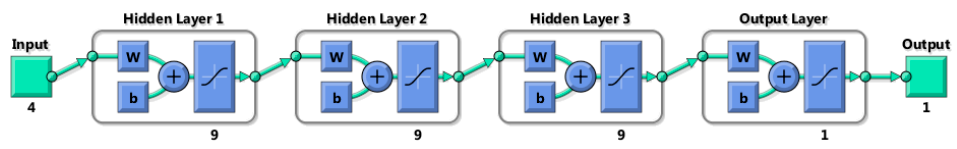
Figure 2. The proposed four-layer neural network model.